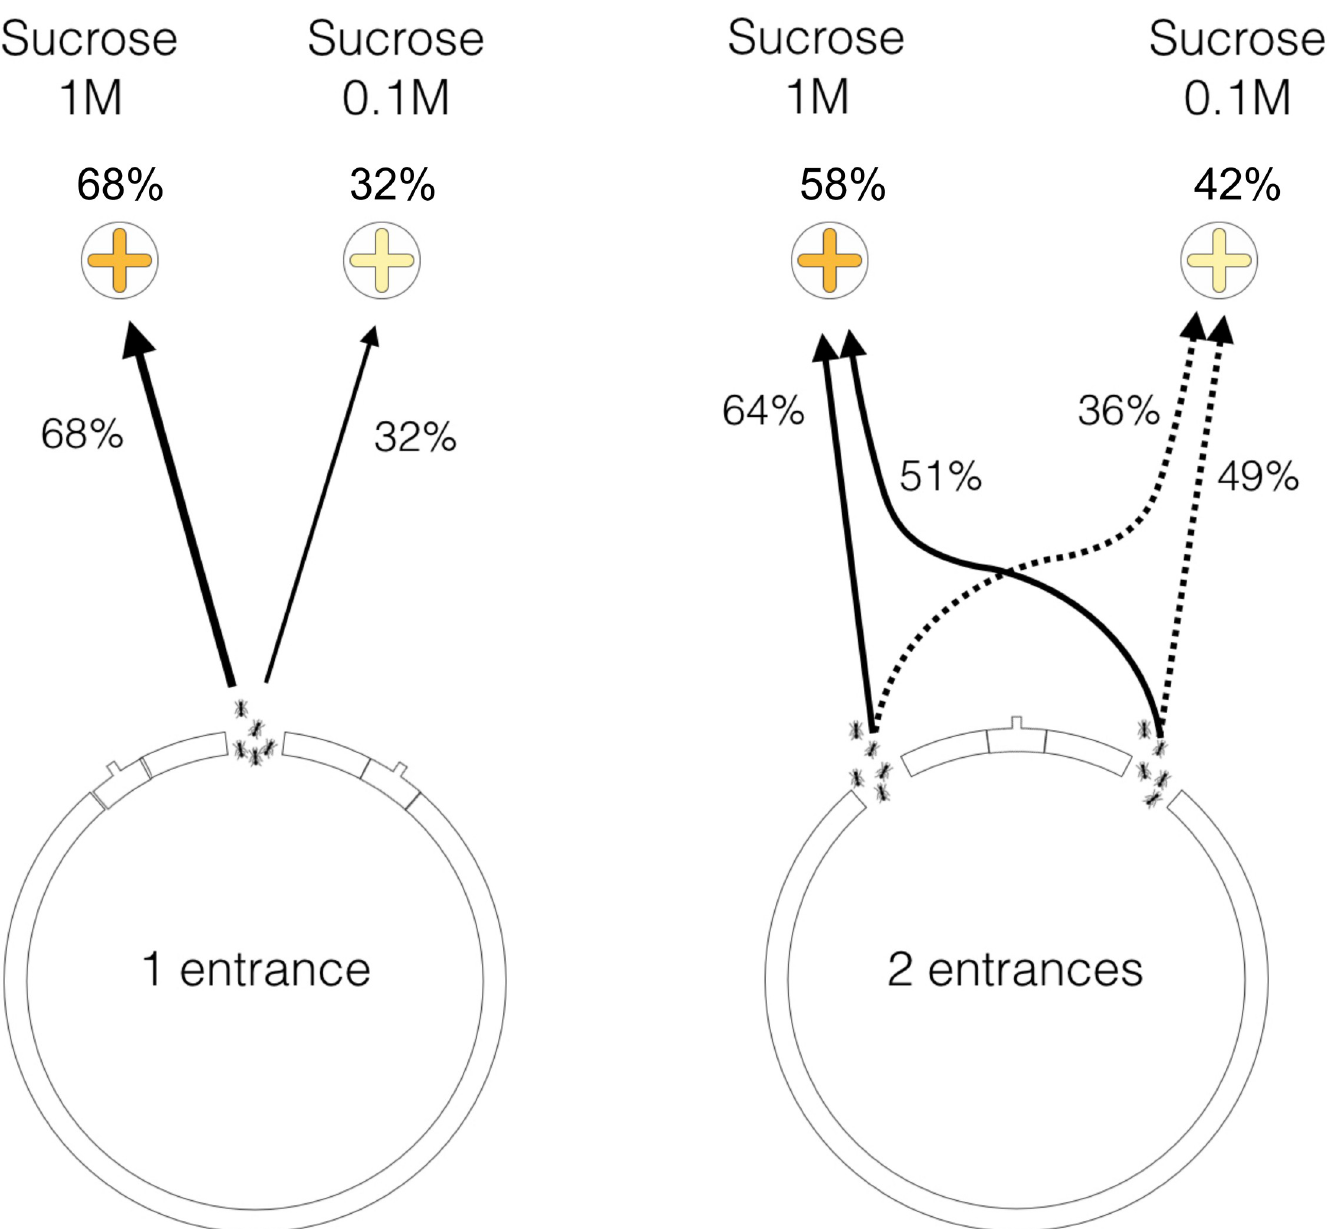
Fig 5. Influence of the nest entrance configuration on the selection of food sources. Among the ant population that reached a food source, the figure shows how ants distribute themselves between each of the two food sources (1M and 0.1M). For one-entrance nests n = 60, for two-entrance nests n = 96.